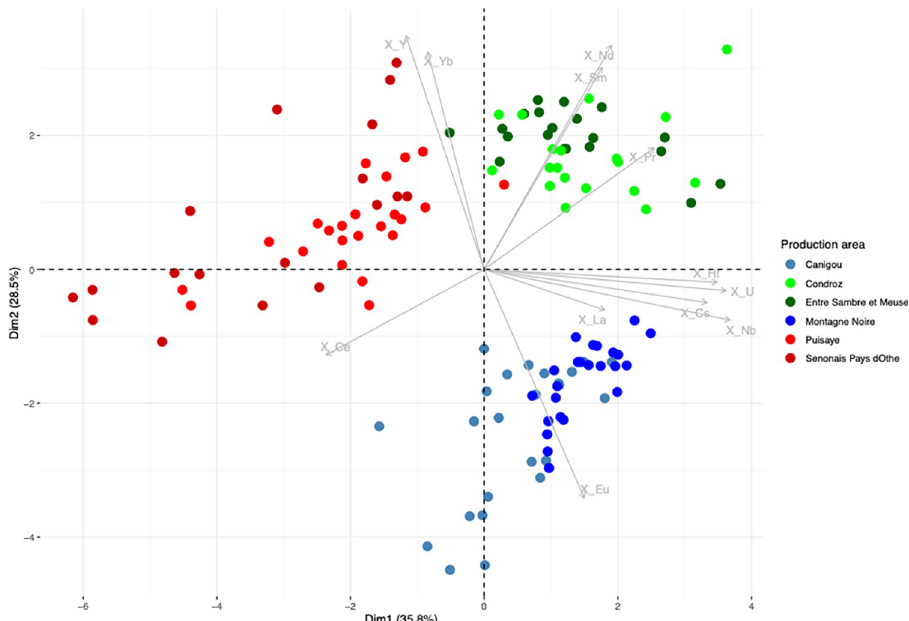
Fig 10. PCA on xij for slag from the production areas. % between brackets: % of total variance.